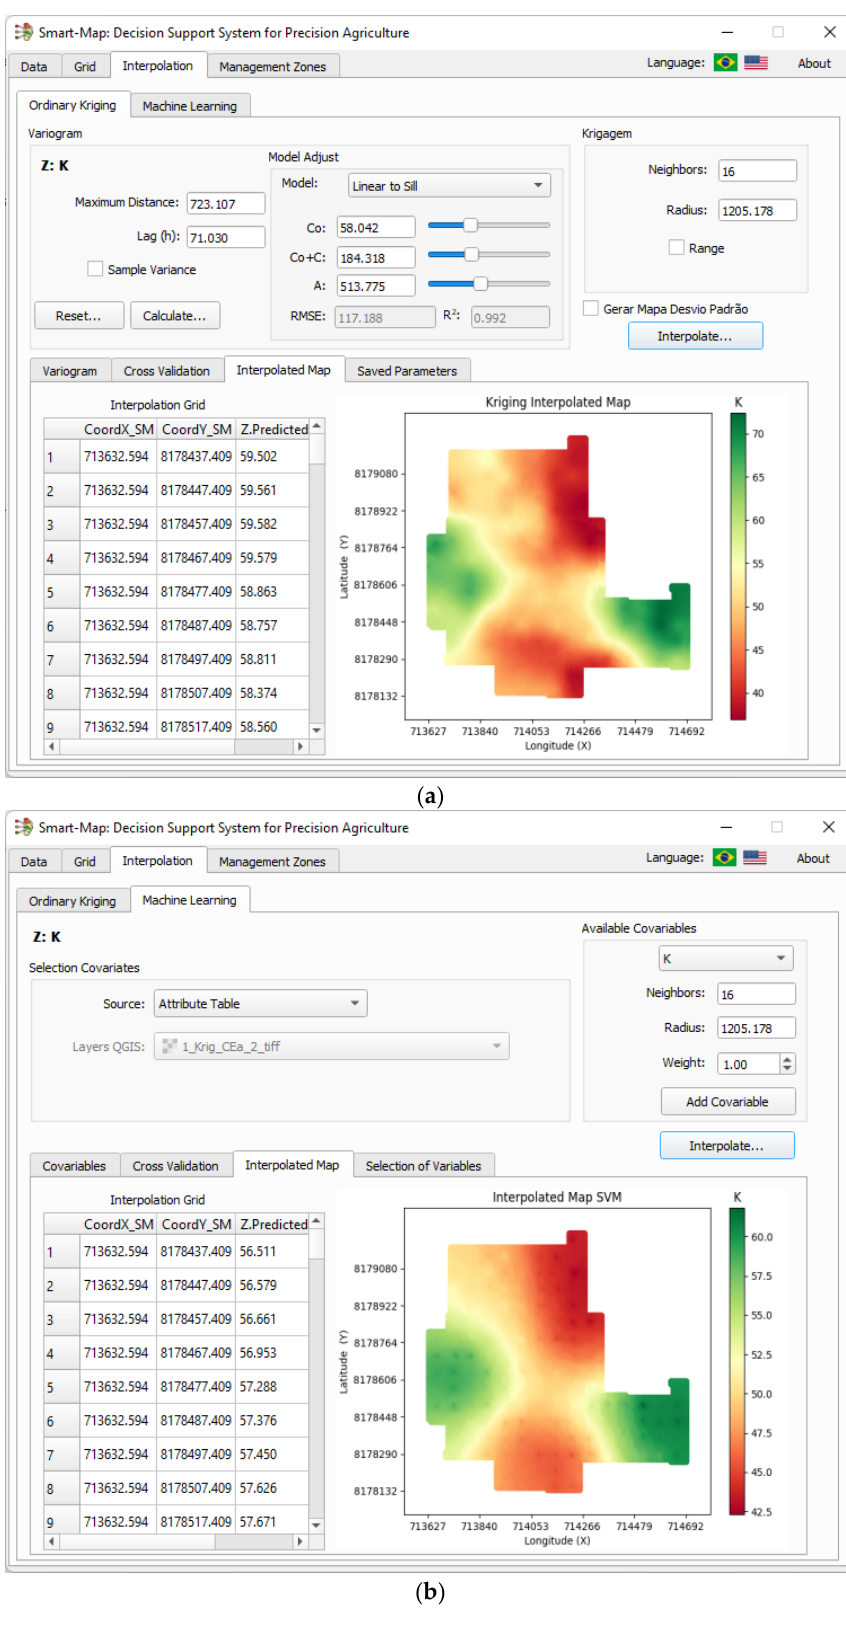
Figure 2. Graphical User Interface of Smart-Map. ( a ) Interpolation by OK. ( b ) Interpolation by SVM